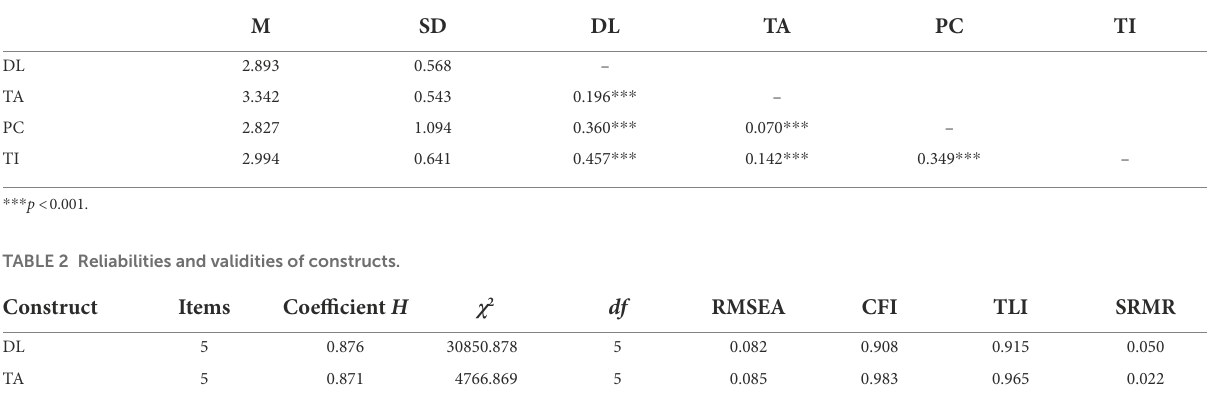
TABLE 1 Descriptive analysis and correlation among variables.